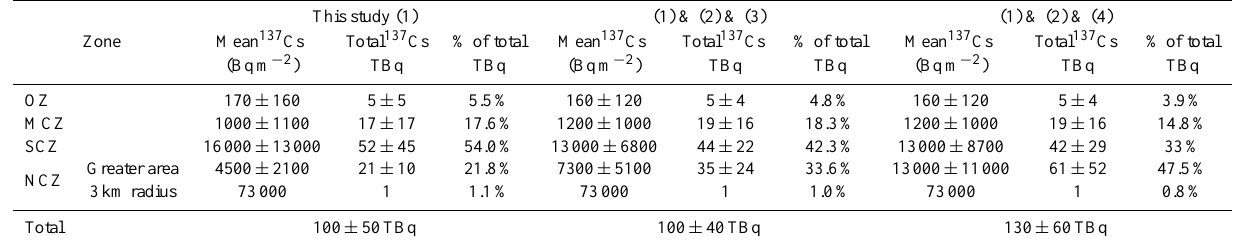
Table 3b. Total 137 Cs inventory results by zone and data sets used. Estimates of total marine sediment 137 Cs inventories were found for this study only ( n = 18) and by including data sets from Otasaka and Kato (2014) and Kusakabe et al. (2013) that were adjusted by zone based on calculated average percent inventories observed below 3 to 10cm. See Table 3a for group